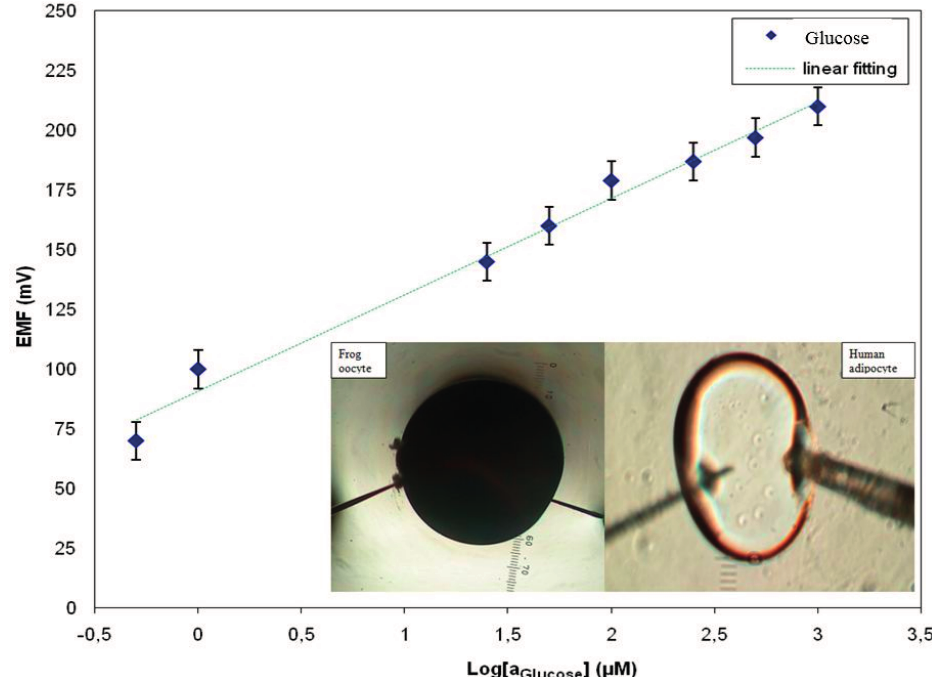
Figure 3. A calibration curve showing the electrochemical potential difference